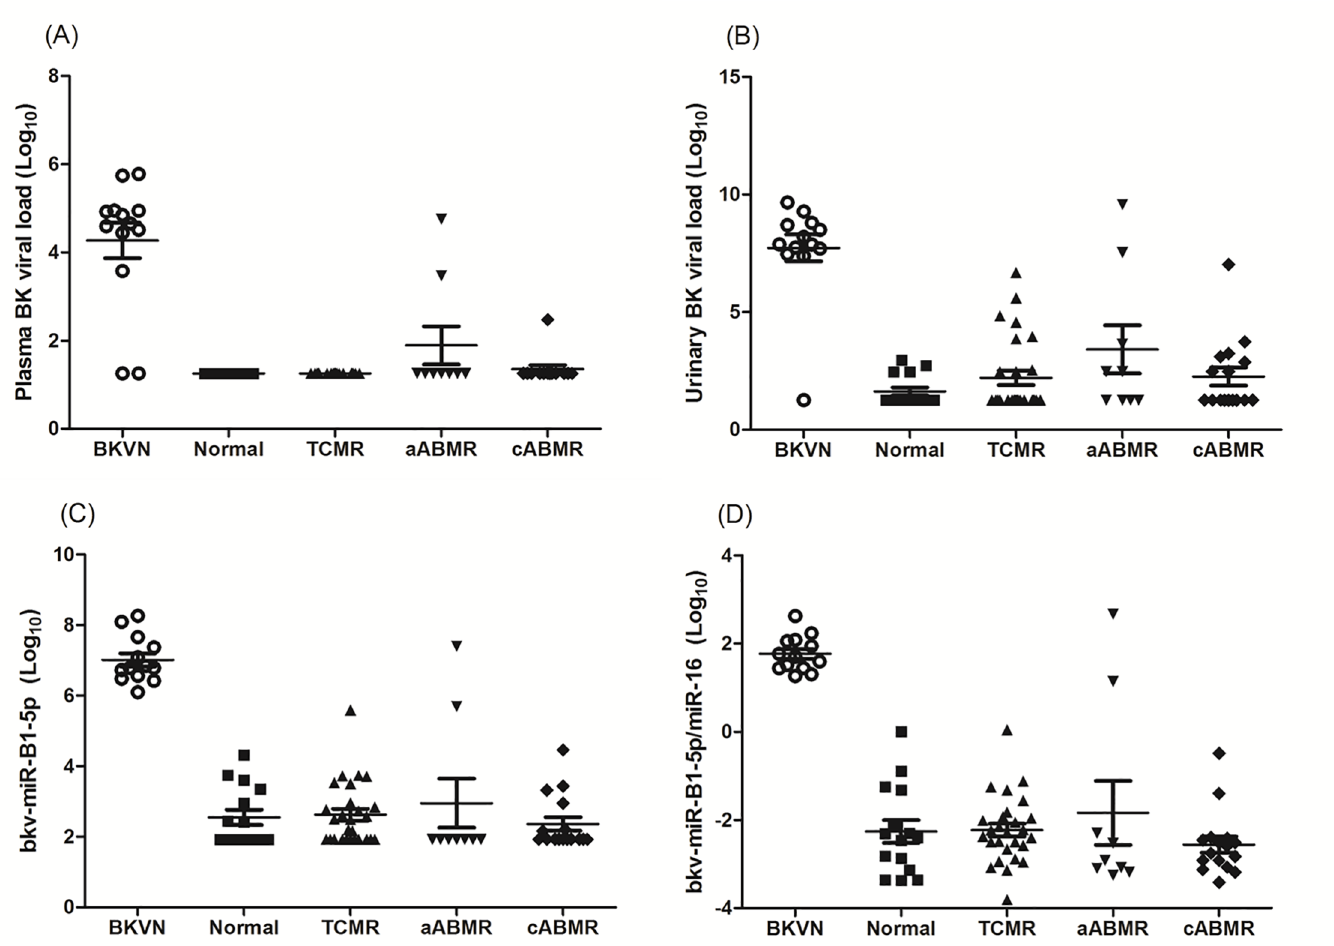
Fig 2. PlasmaBK viral load, urinary BK viral load, urinary exosomal bkv-miR-B1-5p, and bkv-miR-B1-5p/miR-16 levels according to renal allograft status. (A) and (B) Plasma and urinary BK viral load was elevatedin patients with BKVN. However, two patients with BKVN showednegativeplasma BK viral load, and one patient showednegativeurinary BK viral load (C) and (D) Patients with BKVN also showedhighestlevels of bkv-miR-B1-5p and bkv- miR-B1-5p/miR-16 ( p < 0.001). All patients in this group revealedpositive urinary BK viral microRNAlevels. Abbreviations; TCMR, T-cell mediated rejection; aABMR, acute antibody-mediatedrejection; cABMR, chronicactive antibody-mediatedrejection;BKVN, BK virus nephropathy.